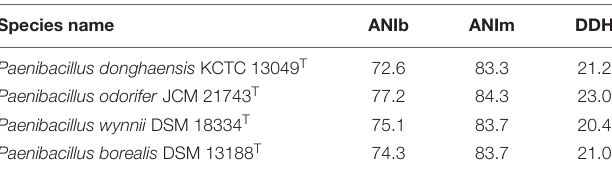
TABLE 1 | Average nucleotide identity (ANIb and ANIm) and DNA–DNA hybridization (DDH) values (%) of strain LC-T2 T with phylogenetically related species of the genus Paenibacillus